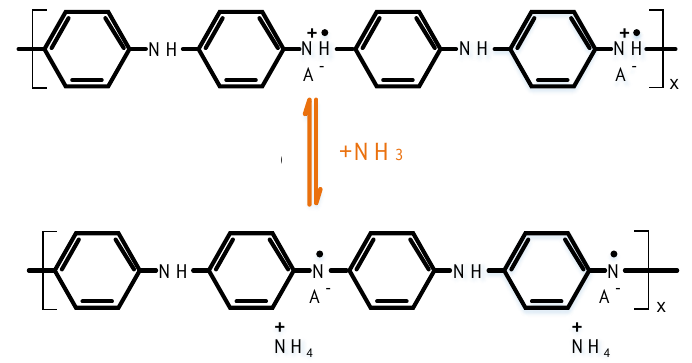
Figure 6. PANI sensitive mechanism to NH 3 : PANI exhibits the property of being a p-type semiconductor. When it comes into contact with an NH 3 molecule with reductive ability, the NH 3 molecule contains an unbonded valence electron and becomes an electron donor. As a result, the number of carriers in polyaniline decreases and the conductivity decreases, while NH 3 molecules are adsorbed between the PANI chains and gas molecules enter the gas-sensing layer. The dielectric permittivity of the gas-sensing layer and gas molecules caused a change due to the larger specific surface area of CNT. PANI and CNT are doped to increase the ability of the sensitive material to adsorb gas molecules so that the gas molecules can adsorb more, which results in greater variation of the mixed dielectric constant and increased changes in sensor frequency.